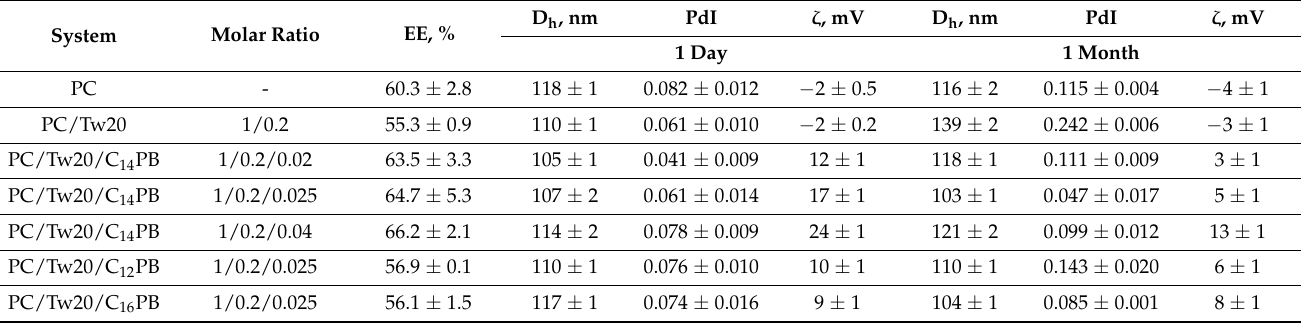
Table 2. Physicochemical properties of modified transfersomes with 2-PAM at different length of the surfactant hydrocarbon tail and ratio of